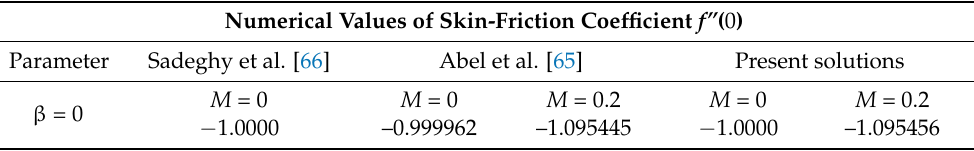
Table 1. Comparison of present solutions with Abel et al. [65] and Sadeghy et al. [66].